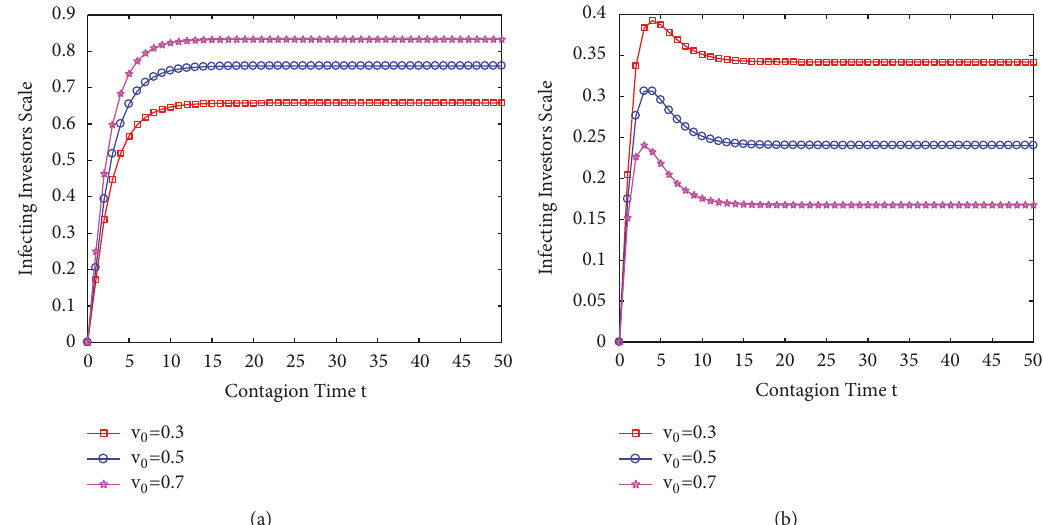
Figure 10: Changes in the scale of infecting investors and immune investors with the contagion time under different information value V 0